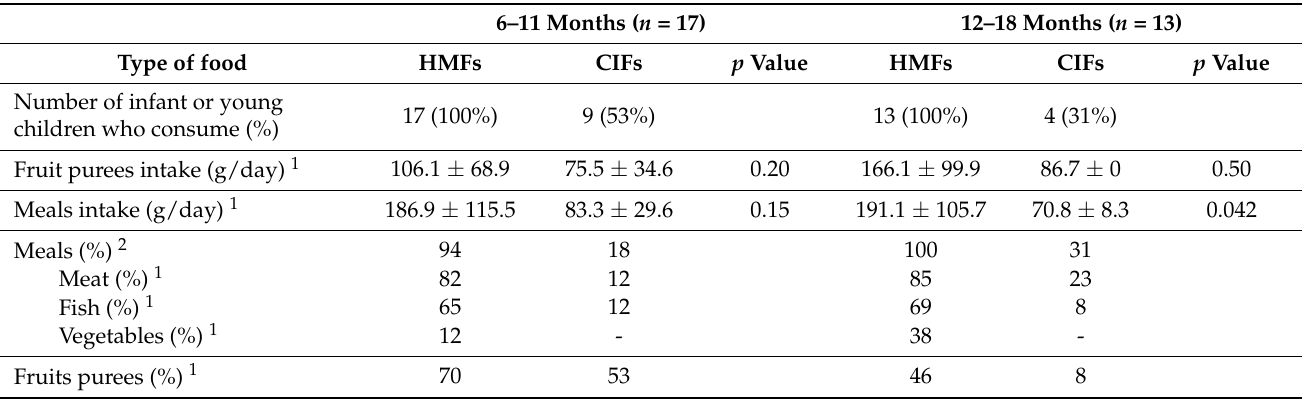
Table 2. Average Daily Intake of Homemade Foods (HMFs) and Commercial Infant Foods (CIFs) from 3-days Weighted Food